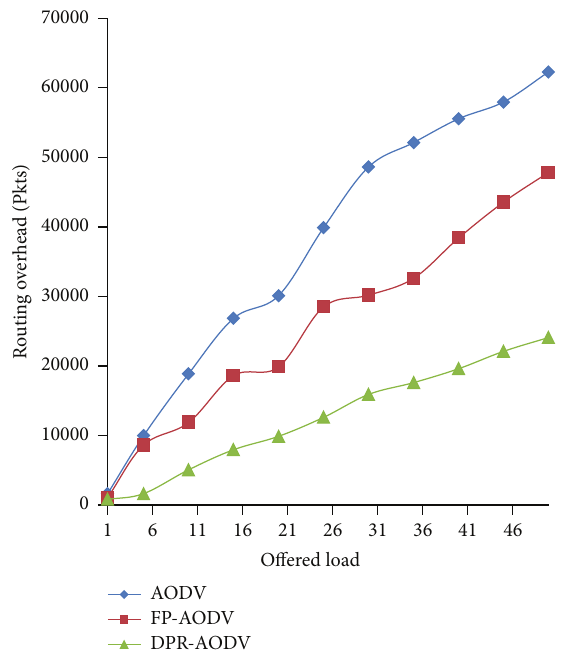
Figure 8: Overhead versus offered Load (in terms of number of packets).